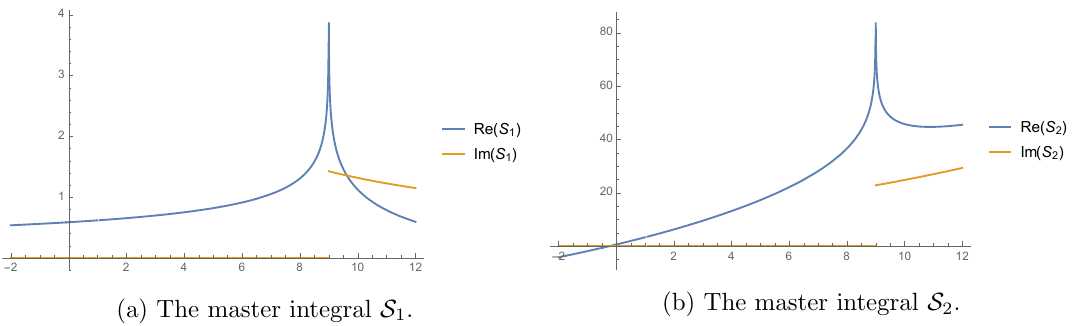
Figure 4. The real and imaginary parts of the two master integrals of the sunrise